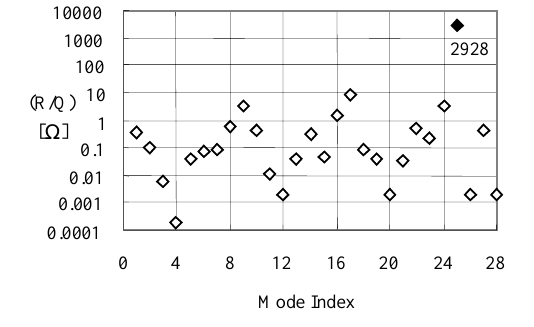
FIG. 13. The computed energy gain when frequencies of the highest (cid:115) (cid:82) (cid:121) (cid:81) (cid:100) modes from the FM passband are set to the nearest harmonics: (a) without compensation, (b) with the injection time compensation.